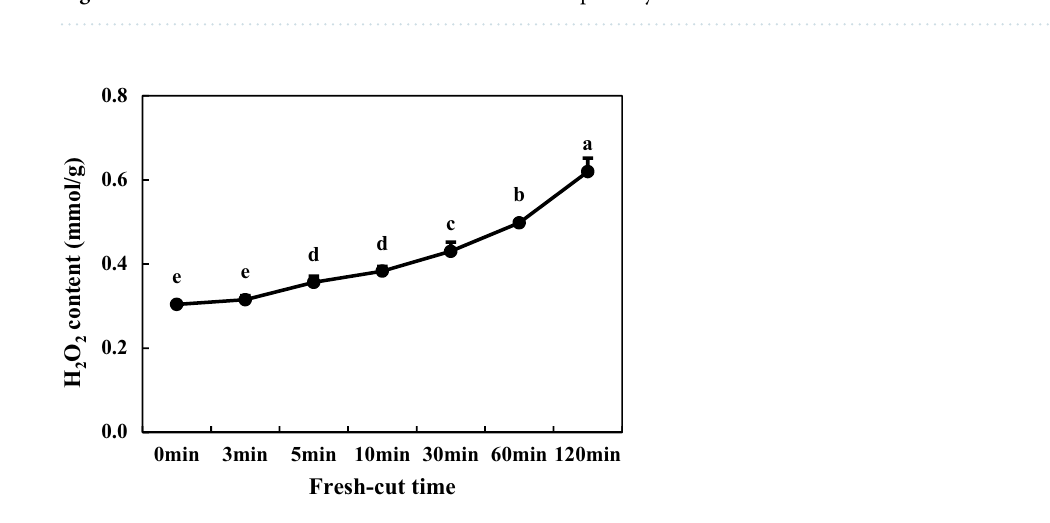
Figure 6. H 2 O 2 content of Fresh-Cut